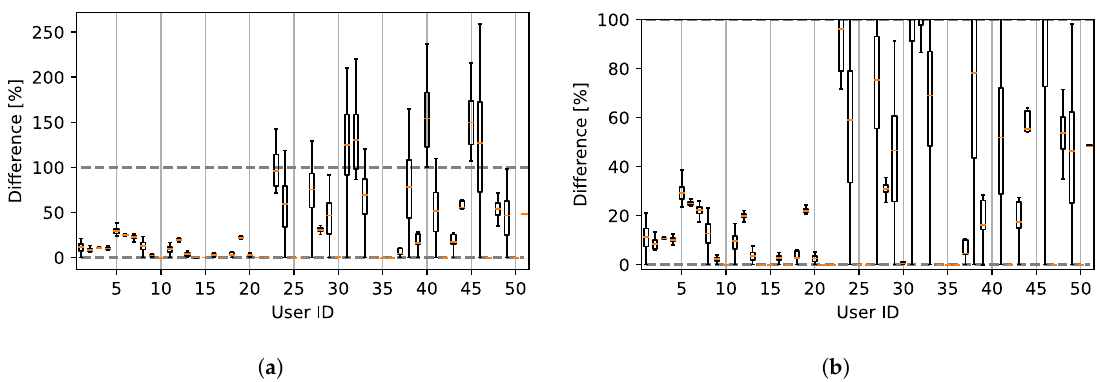
Figure 13. Price comparison, difference between Case 1 and Case 4. ( a ) Complete. ( b )